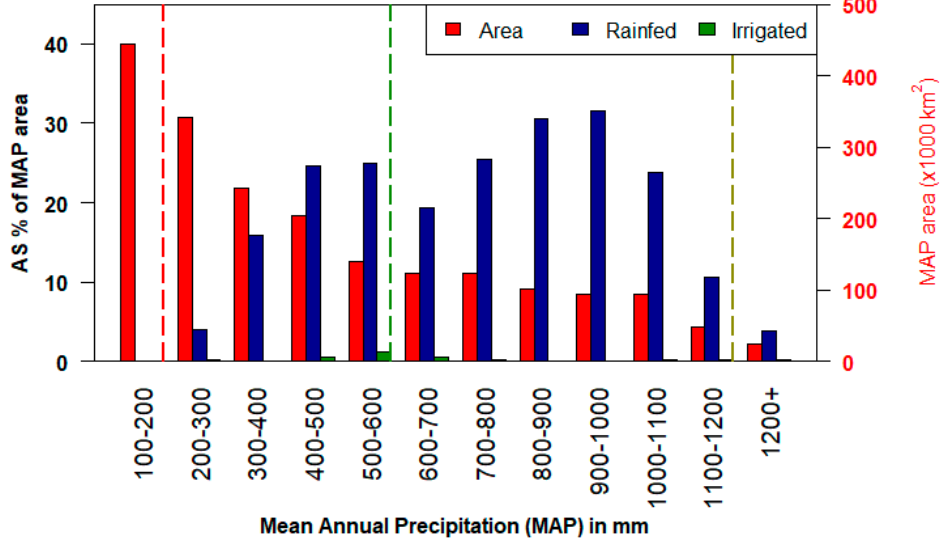
Figure 11. Rainfed and irrigated cropland as percentage of the total area in MAE interval (e.g., The total area of 800–900 mm zone is about 100 × 10 3 km 2 , and the fraction of this area occupied by rainfed cropland is about 30%).